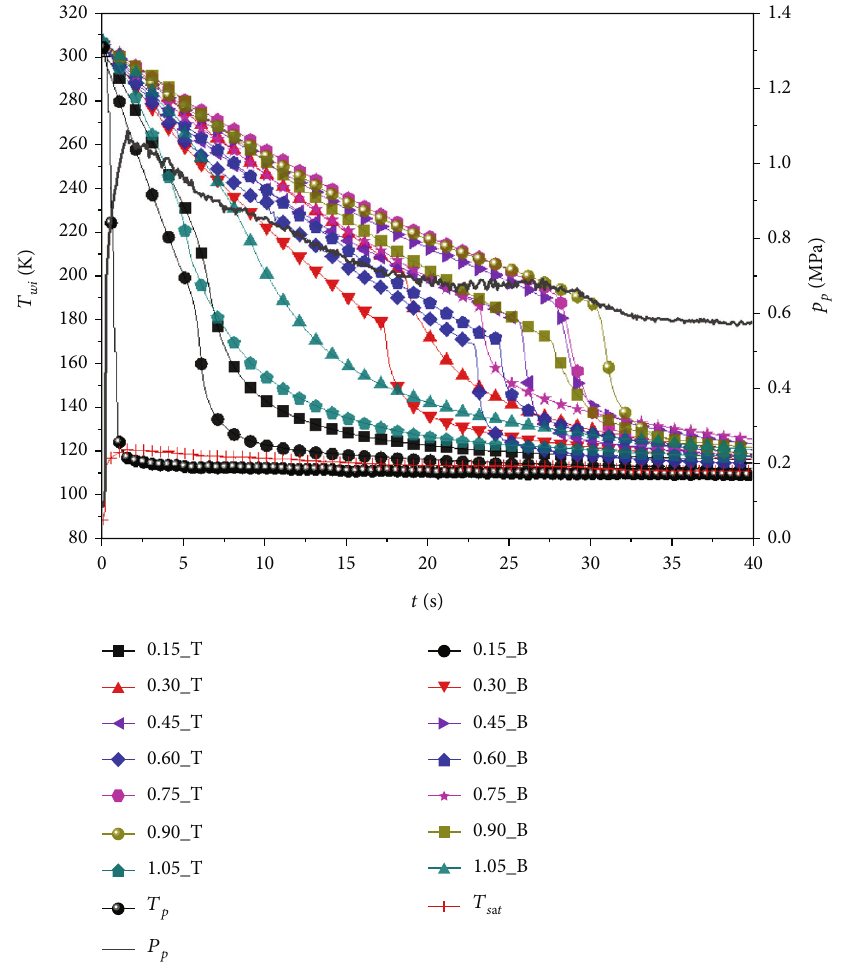
Figure 3: Data curves for Exp. 1 ( _ m = 0 : 568 kg/s , p